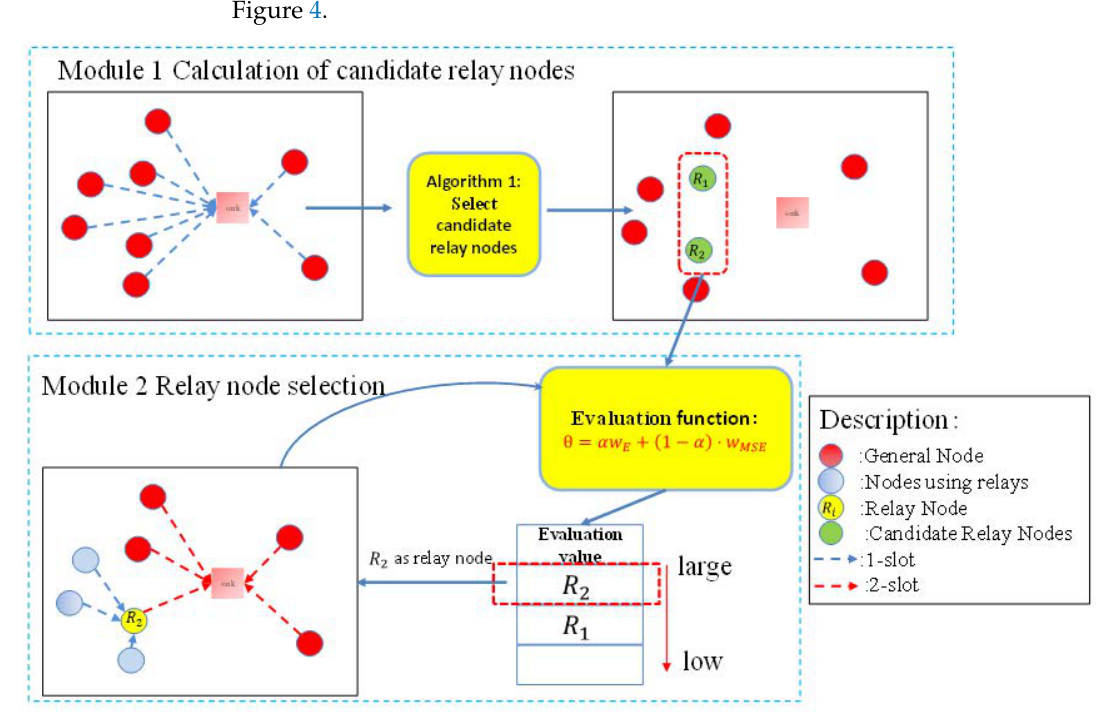
Figure 4. System model of